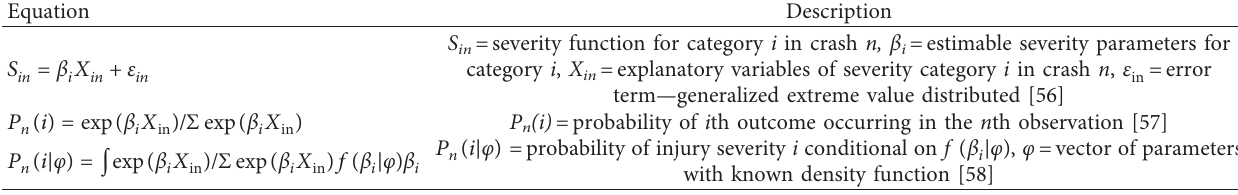
Table 1: Equations used in the mixed multinomial logit model formulation.